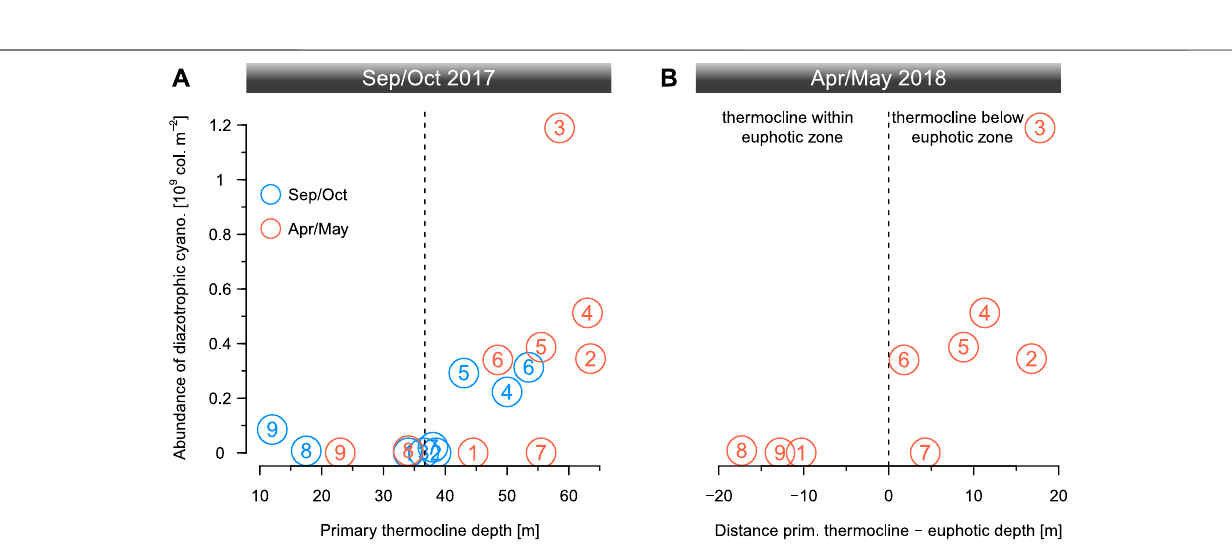
Frontiers in Environmental Science |